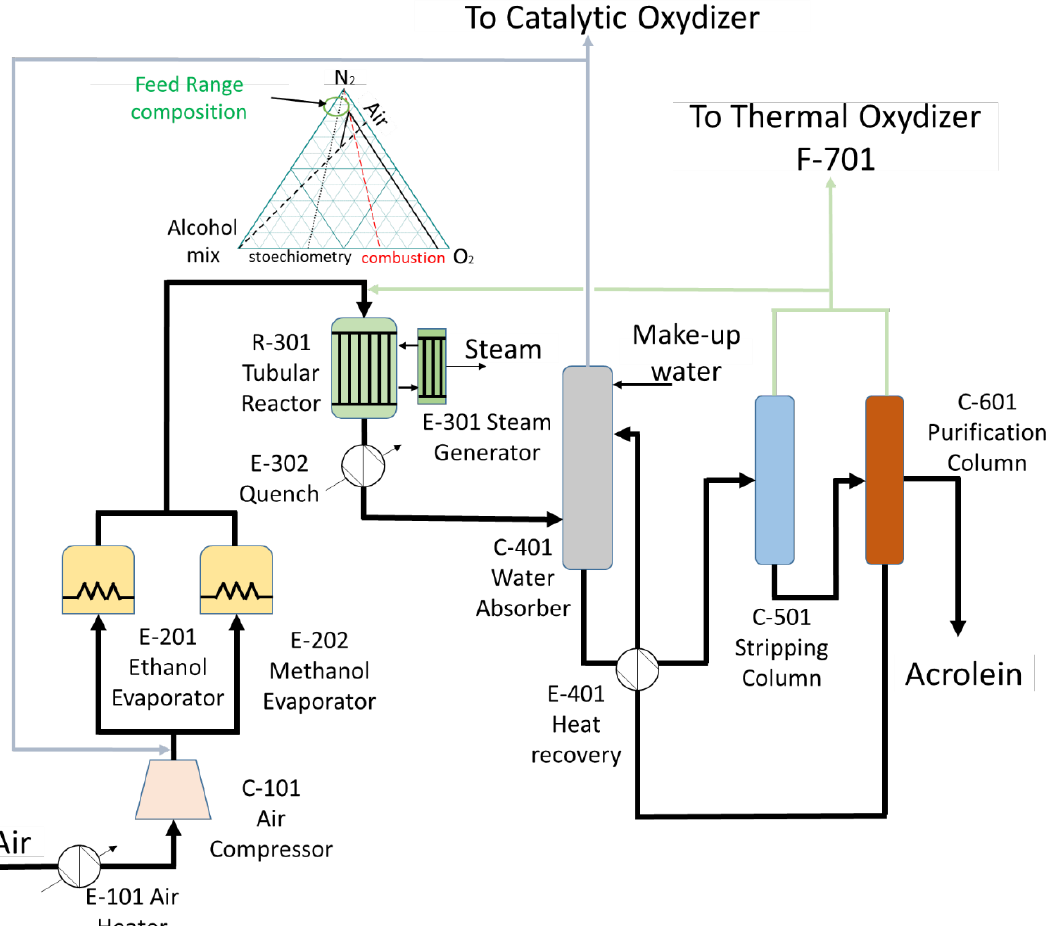
Figure 5. Proposed process flow diagram of the new “Oxidative Coupling of Alcohols” route.